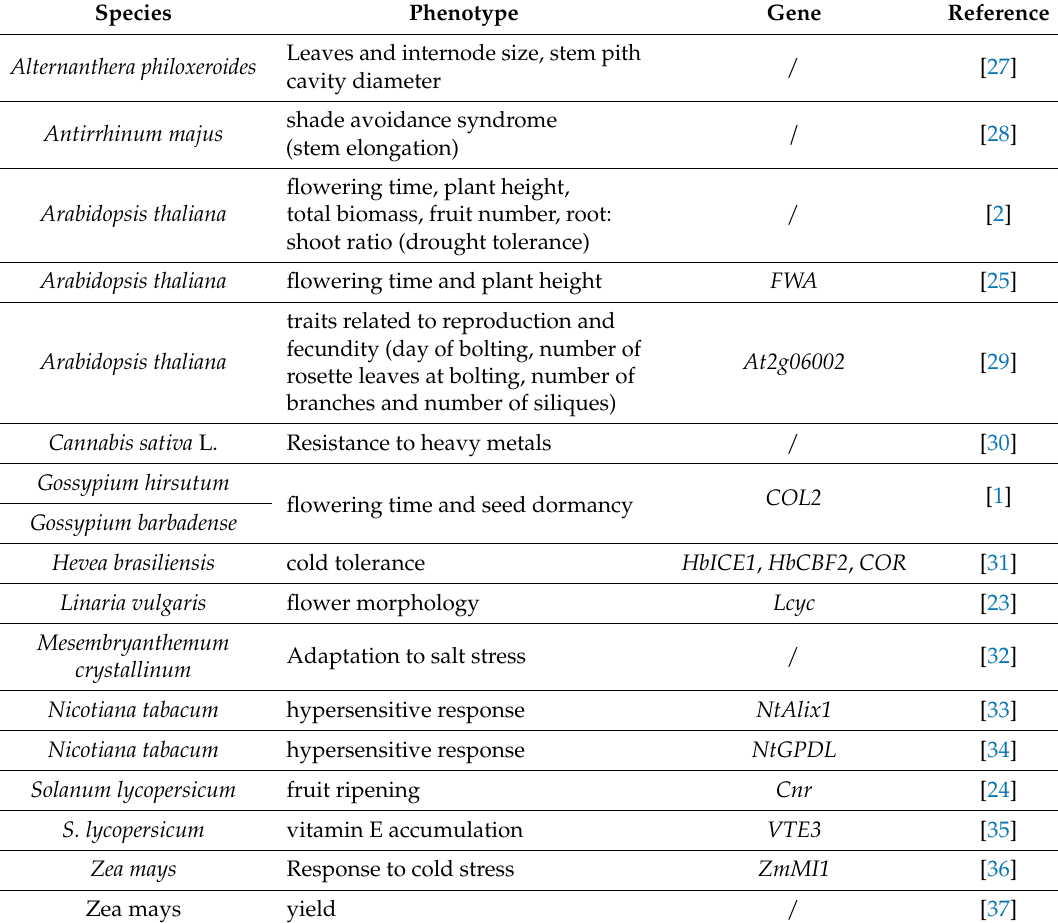
Table 1. Examples of phenotypic traits sensitive to epigenetic